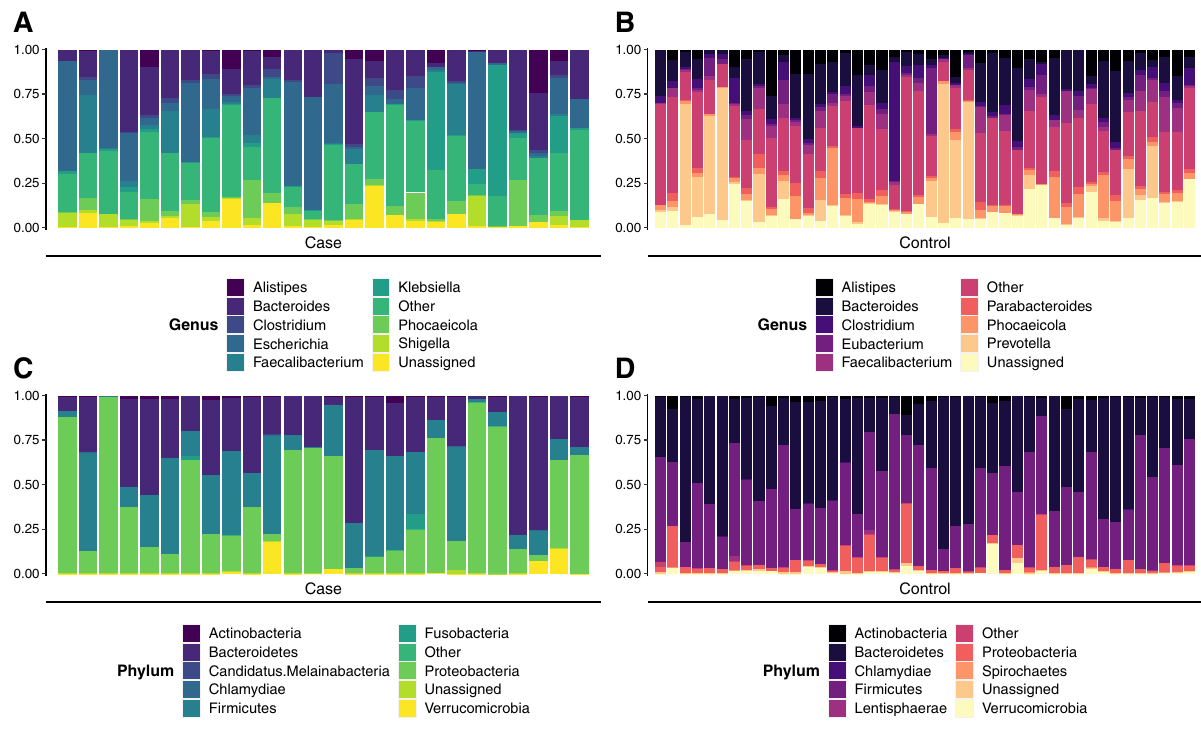
Figure 5. Taxonomic relative abundance notably differs between cases and controls. The relative abundance of bacterial genera and phyla in each sample are displayed as columns for cases ( A , C ) and controls ( B , D ). Similar to ARG relative abundance, taxonomic relative abundances were determined using raw abundances that had been normalized by the approximate number of genome equivalents in the sample as determined using MicrobeCensus. For the phylum and genus levels, the top-10 phyla and genera were chosen, respectively, based on the highest average relative abundance assigned to a specific phylum or genus among cases or controls (which were considered separately). The remaining read abundances for phyla or genera in samples were summed and are shown in the category “Other.” Note: plots for cases ( A , C ) and controls ( B , D ) contain the same respective color schemes but that these refer to genera ( A , B ) and phyla ( C , D ),